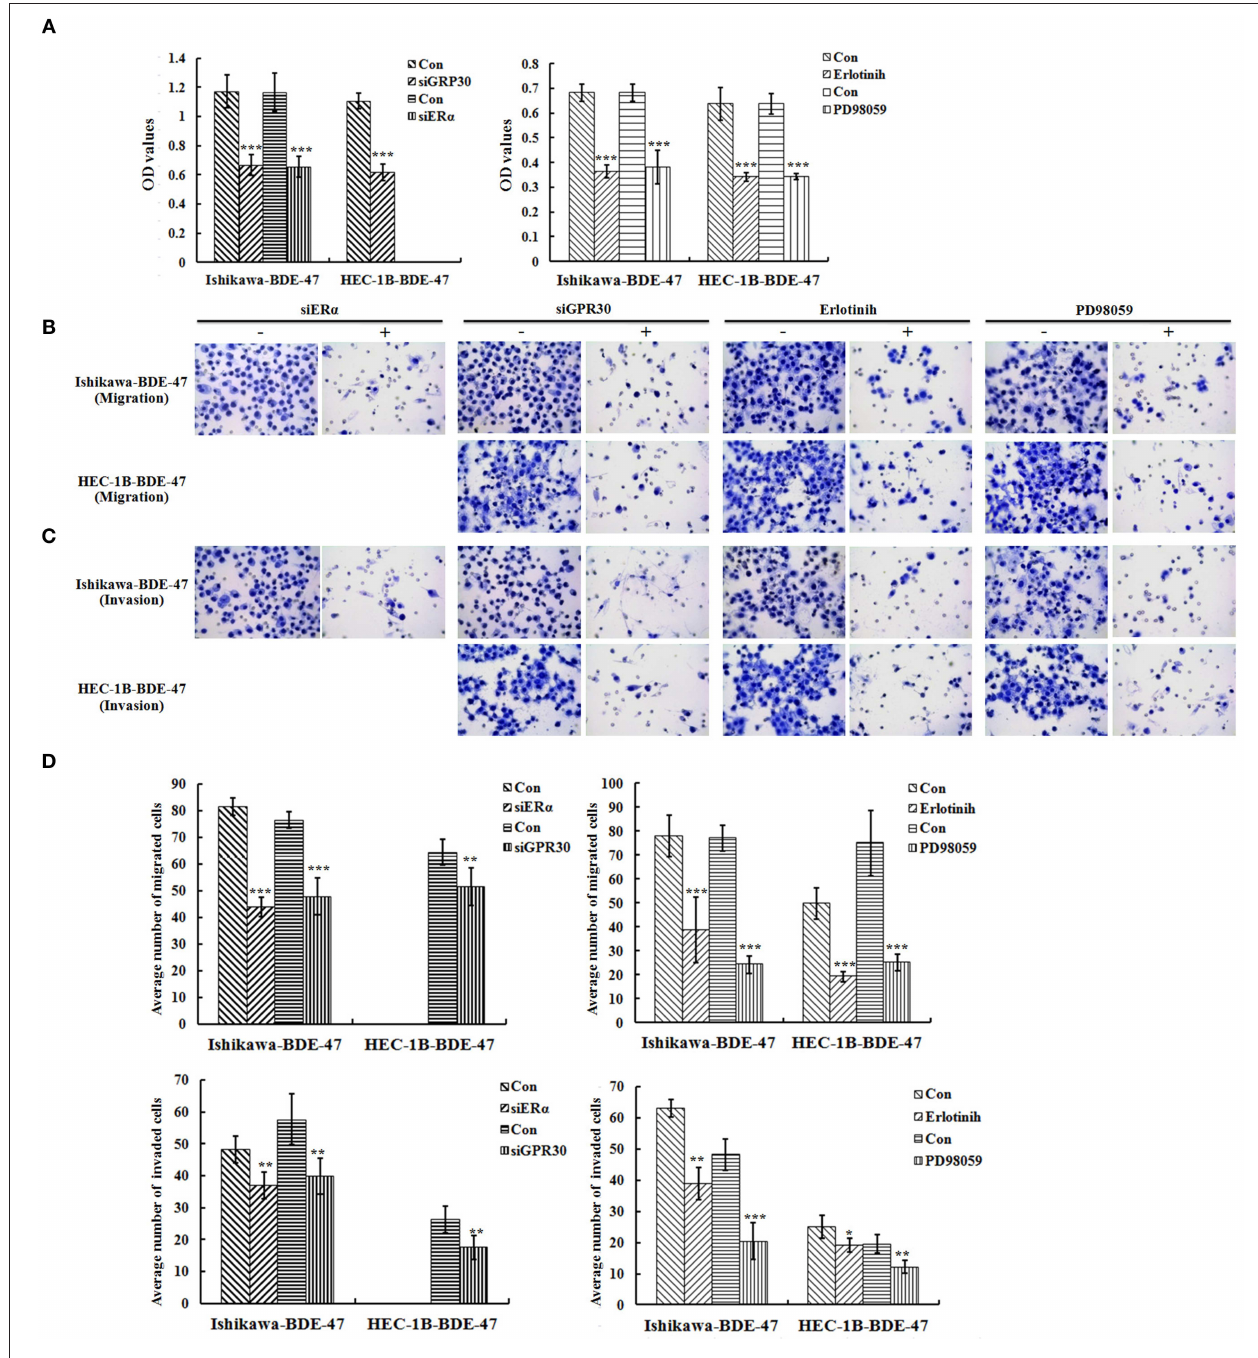
FIGURE 4 | Role of ER α /GPR30 and EGFR/ERK signaling pathway underlying the viability and metastatic effect induced by BDE-47. (A) Cell viability of Ishikawa-BDE-47 and HEC-1B-BDE-47 cells at 72h after transfection with siER α or siGPR30, or the treatment with pEGFR inhibitor (erlotinib) or pERK inhibitor (PD98059) for 48h. (B–D) The migration and invasive capacity of Ishikawa-BDE-47 and HEC-1B-BDE-47 cells after transfection with siER α or siGPR30, and treatment with pEGFR inhibitor (erlotinib) or pERK inhibitor (PD98059). Representative images (400 × ) of cell migration (B) and invasion (C) are shown. Con: refer to Ishikawa-BDE-47 or HEC-1B-BDE-47 without any other treatment. * P < 0.05; ** P < 0.01; *** P < 0.001.